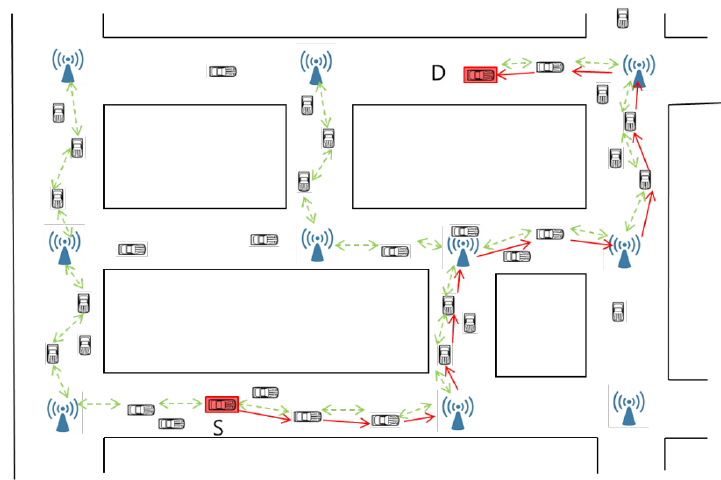
Figure 5. Routing based on fuzzy multi-factor decision (IRFMFD) protocol model.